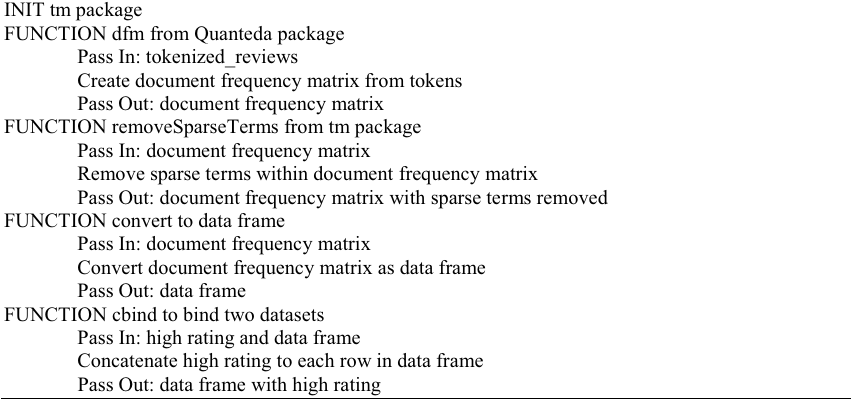
Table 4 Pseudocode to create Document Frequency Matrix (DFM) and data frame from the tokens INIT tm package FUNCTION dfm from Quanteda package